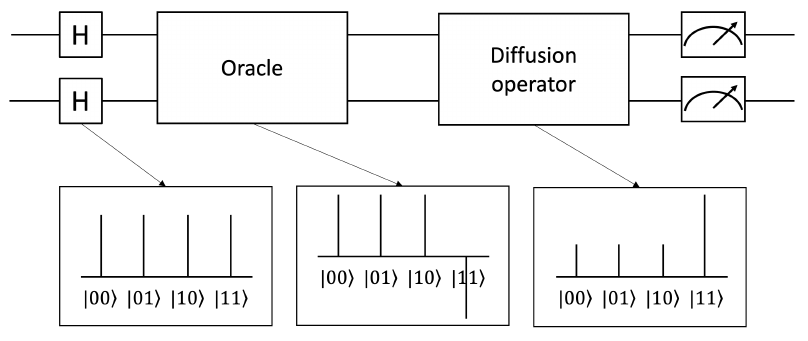
Figure 4. Grover’s algorithm (answer x =